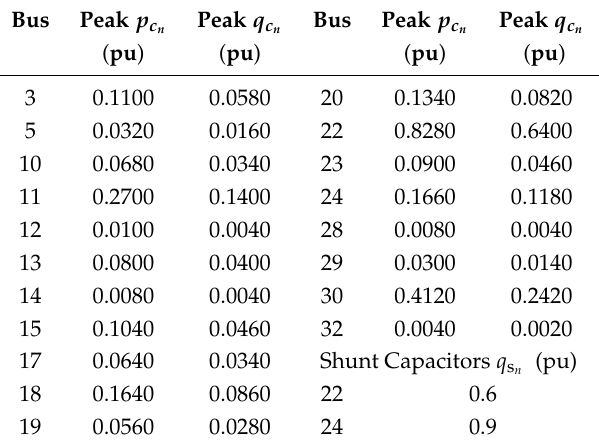
Table 2. Peak real and reactive load and shunt capacitors [35].